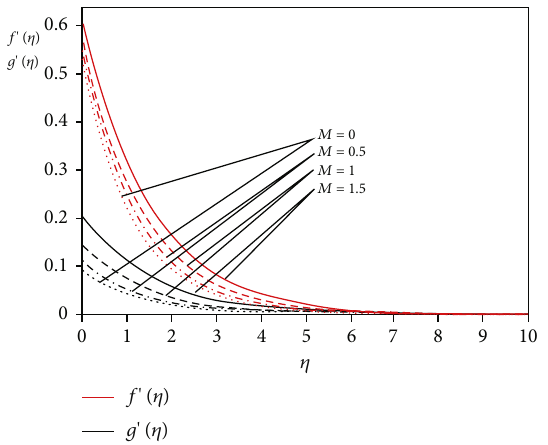
Figure 3: Velocity pro fi les a ff ected by magnetic fi eld parameters.